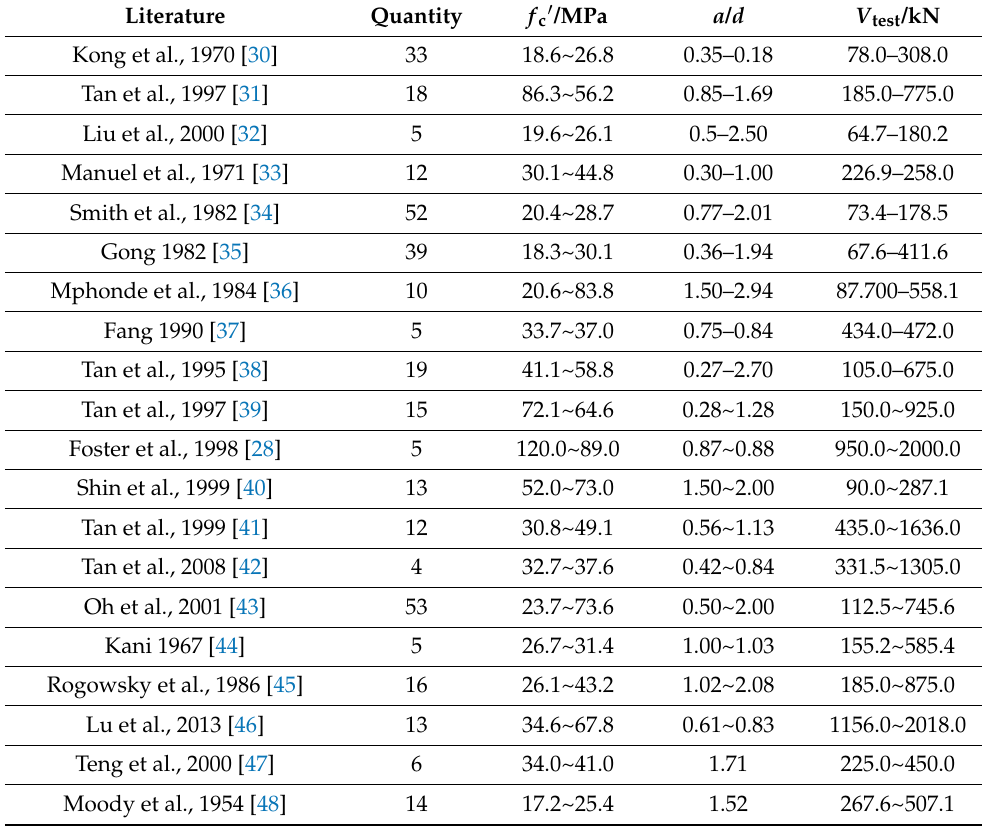
Table 1. Deep-Beam